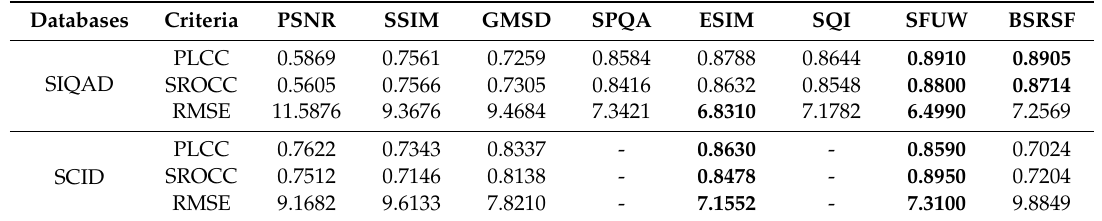
Table 1. Performance comparison of the proposed BSRSF model and full-reference (FR) models.